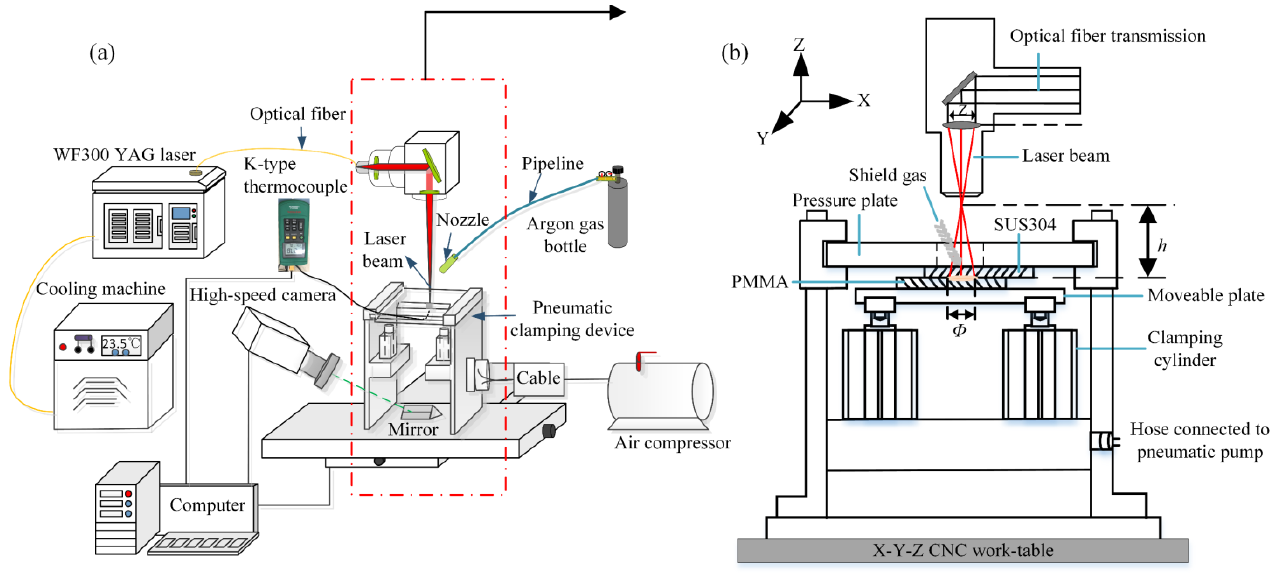
Figure 1. ( a ) Experimental apparatus used for laser joining PMMA and steel and ( b ) schematic diagram of the laser light path. Adapted with permission from ref. [31]. Copyright 2021 Optics and Laser Technology.